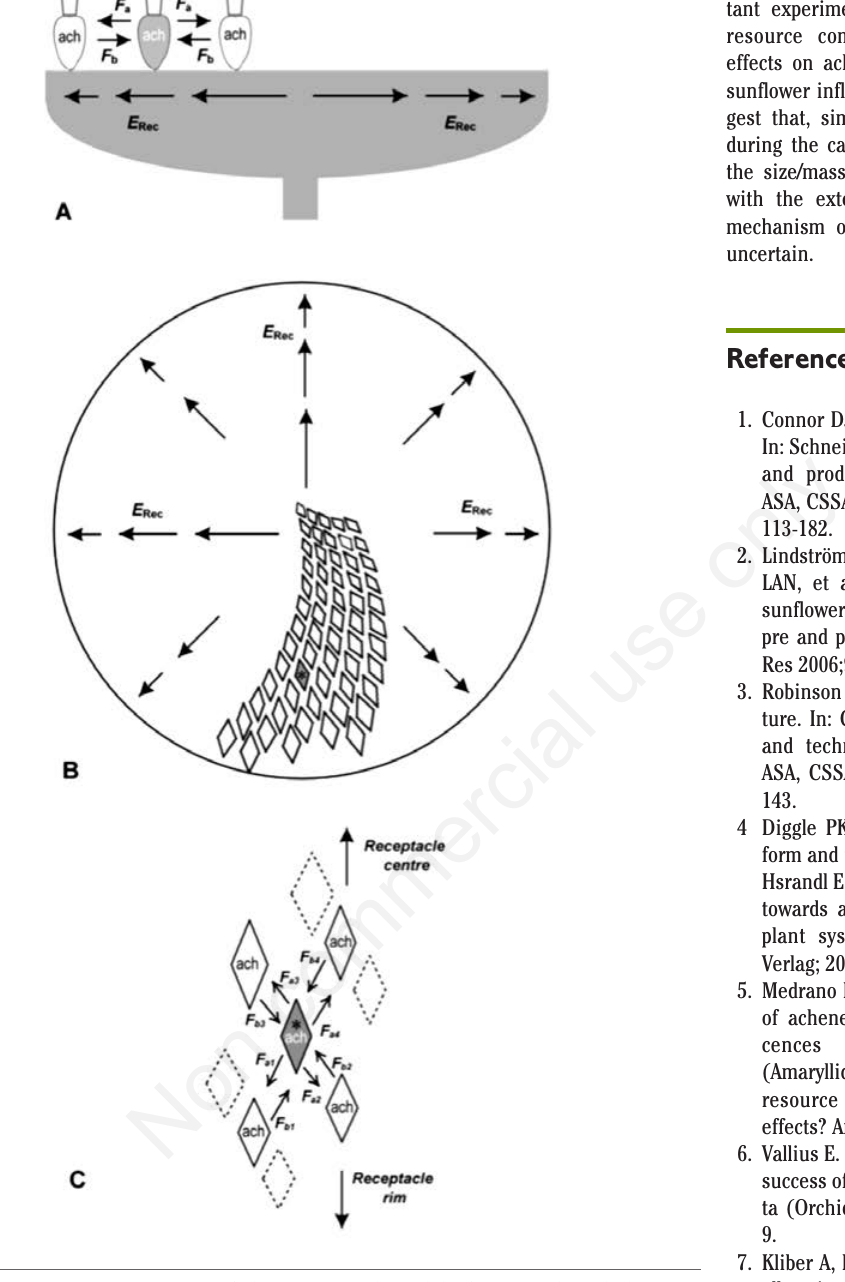
Figure 3. Schematic representation of the conceptual model of receptacle radial expan- sion, achene growth spatial competition. Simplified model of achene growth from the point of view of forces interacting during the development of a given achene on the recep- tacle surface. While the whole receptacle is radially expanding (A, B) each growing achene confronts with the competition for space with its neighbors (C). ach: achene; F : expan- a1-4 : expansion forces exerted by neighboring sion forces exerted by a particular achene. F b1-4 achenes. Regarding the neighboring achenes developmental age, because its relative posi- >F >F >F i s tion in the receptacle (C), then F . For simplification of the model, F b1 b2 b3 b4 a1-4 equal in all directions. E receptacle radial expansion. Different arrow lenght represents rec: the expansion rate magnitude gradient into the receptacle after R8, as observed by Hernández